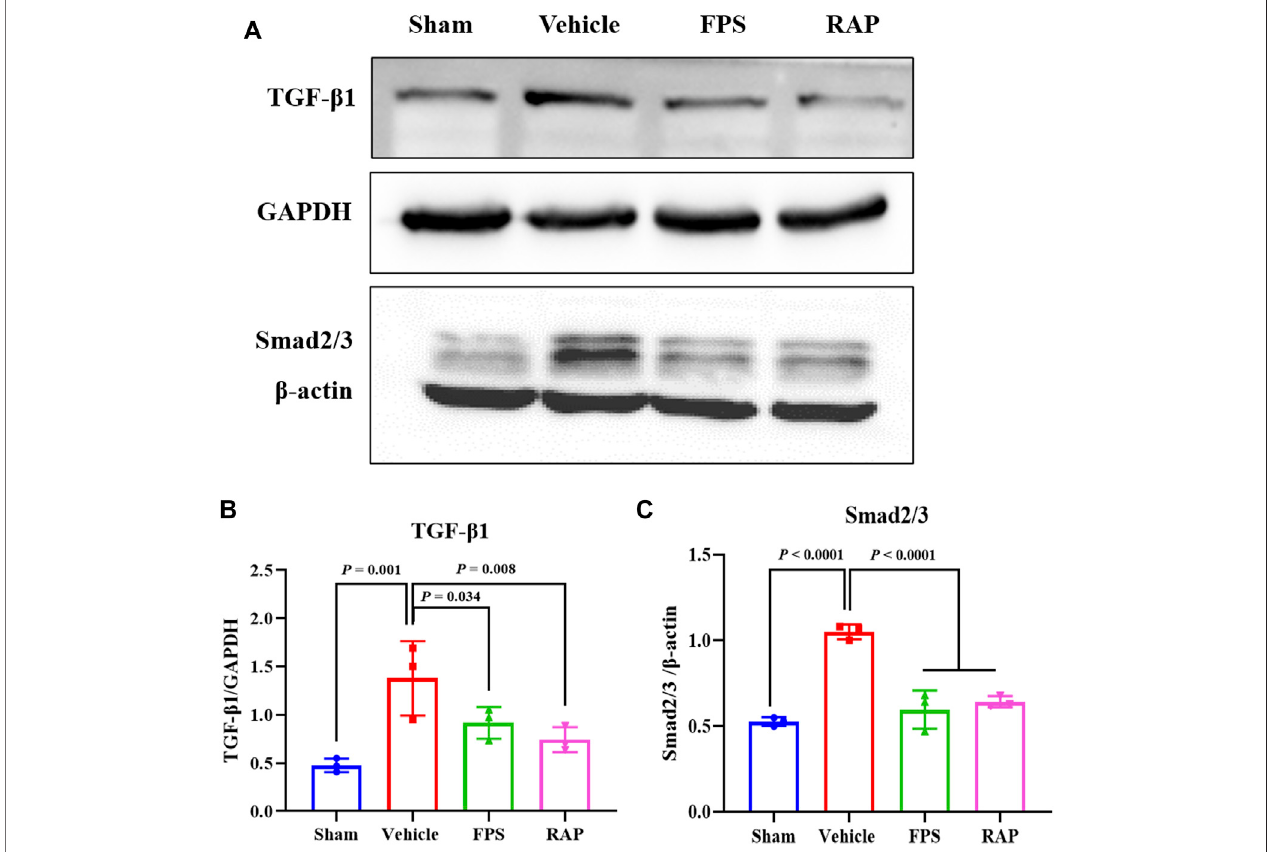
FIGURE3| EffectsofFPSandRAPontheTGF- β 1/Smad2/3pathway invivo . (A) TheWBanalysisofTGF- β 1andSmad2/3Iinthediabetickidneys. (B,C) Therate of TGF- β 1 and Smad2/3 to GAPDH or β -actin, respectively. The data are expressed as the mean ± SD.